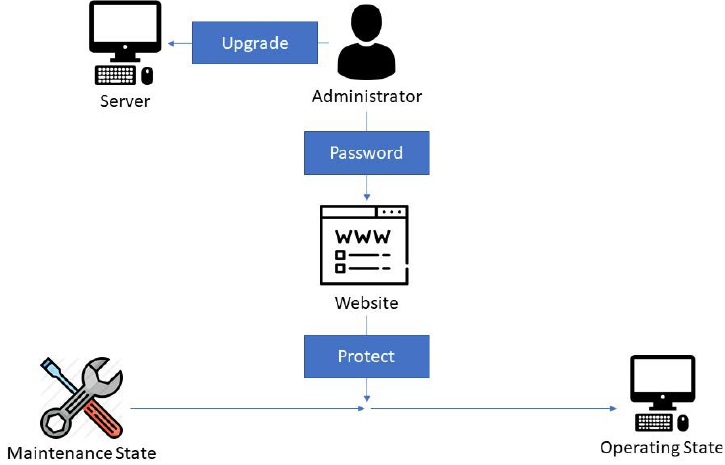
Figure 12. Diagram of the maintenance state for the protect function process.